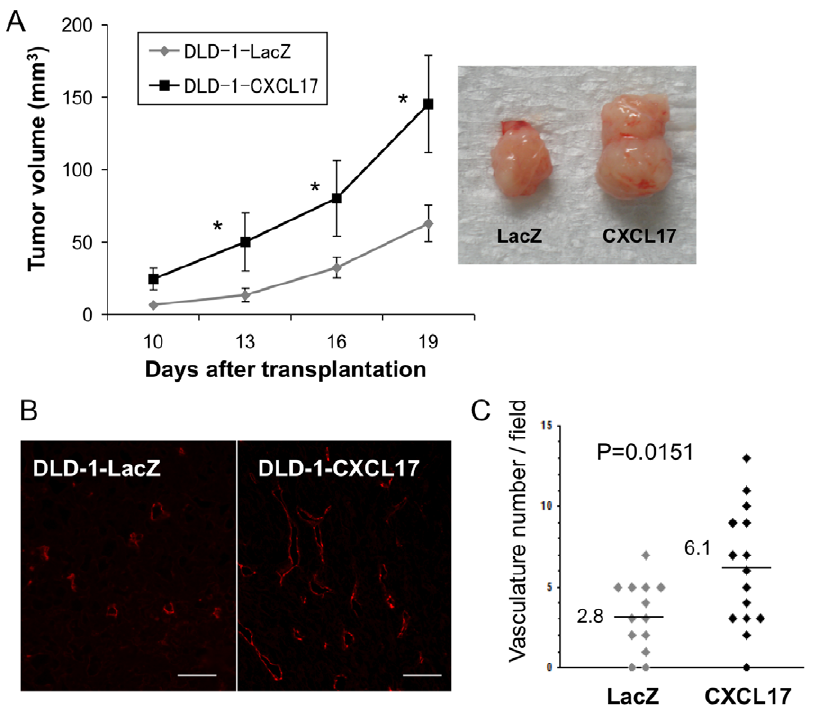
Figure 3. Enhanced tumor formation in CXCL17-expressing DLD-1 colorectal cancer cells. (A) Transfected DLD-1 cells (1 6 10 6 ) were transplanted into the subcutaneous space of C.B-17 SCID mice and tumor volume was measured at the indicated time points (left panel). *, P , 0.05 (mCXCL17 versus LacZ transduction: n=3 2 4 per group). One of three independent experiments with similar results is shown. Right panel, representative tumors isolated from mice at the end of the observation period. (B) Immunostaining of tumors from DLD-1 cells probed by anti-CD31 Ab. Left, LacZ-transduction; right, CXCL17-transduction. Scale bar: 100 um. (C) The number of CD31-positive vasculatures per field. CD31-positive vessels were counted in five random sections. One of three independent experiments with similar results is shown.